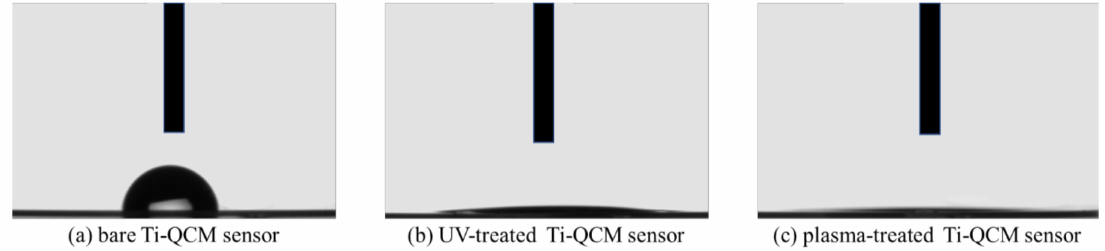
Figure 4. Photographs of the contact angles of water on the surfaces of the ( a ) bare, ( b ) UV-treated, and ( c ) plasma-treated Ti-QCM